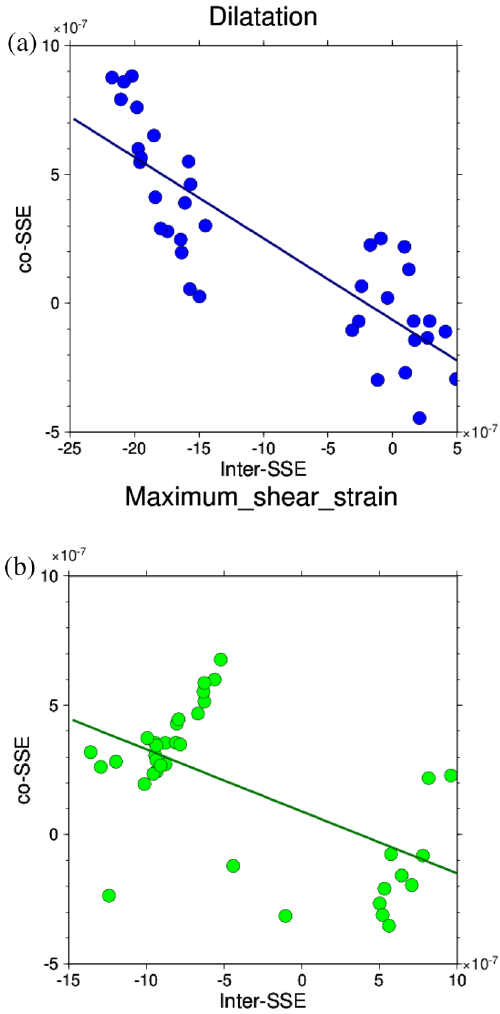
Figure 5. Correlation diagram between the amount of strain accumulated before the Bungo Channel L-SSE (2) (7 February 2011–19 April 2018) and the amount of change in strain during the L-SSE occurrence (20 April 2018–26 May 2019). The values of the dilatation and the maximum shear strain at the calculation points shown in Fig. S2d are used. The expressions of the figures are the same as those in Fig. 3a and